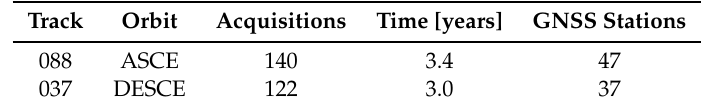
Table 1. Netherlands Dataset.